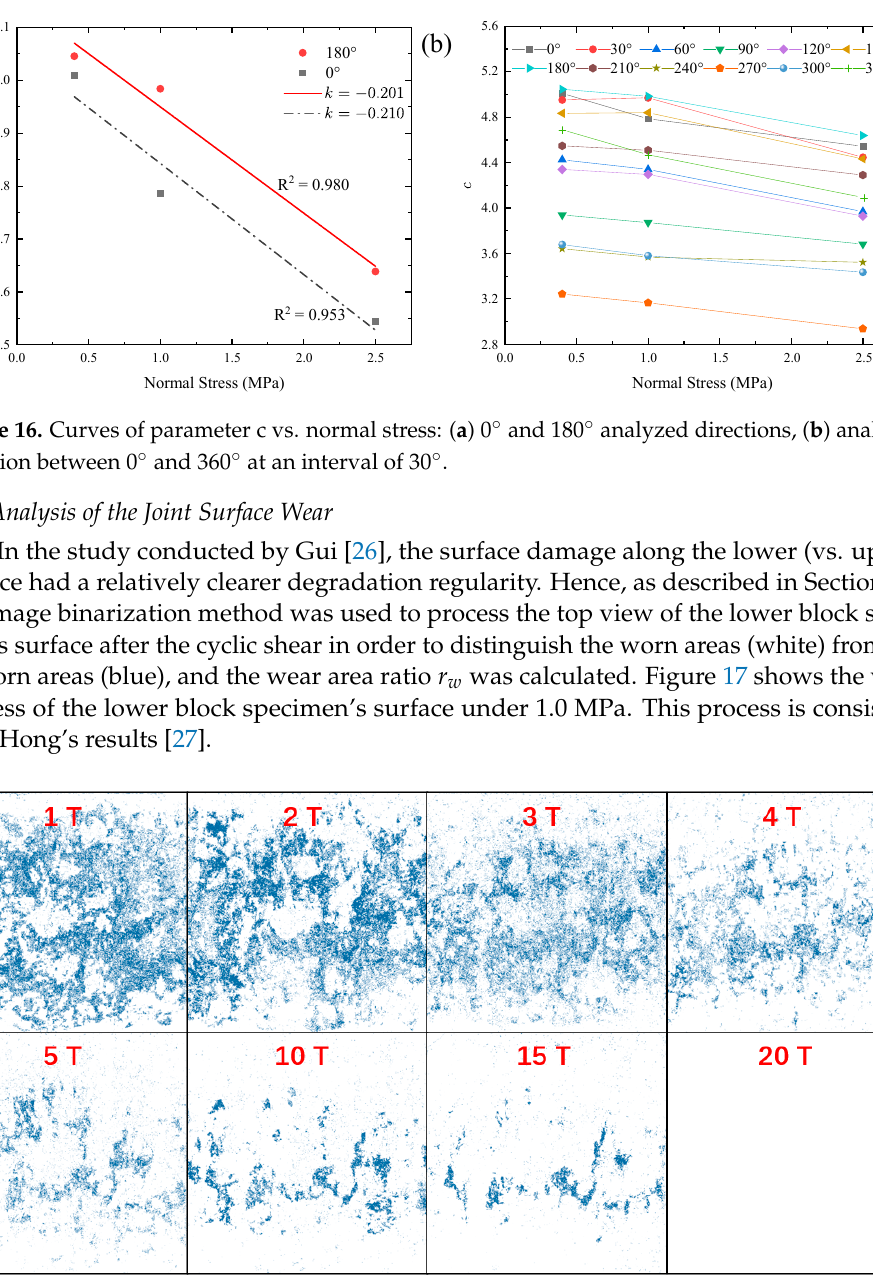
Figure 17. Using the image binarization method to process the worn (white area) and unworn areas (blue area) of the surface under 1.0 MPa.